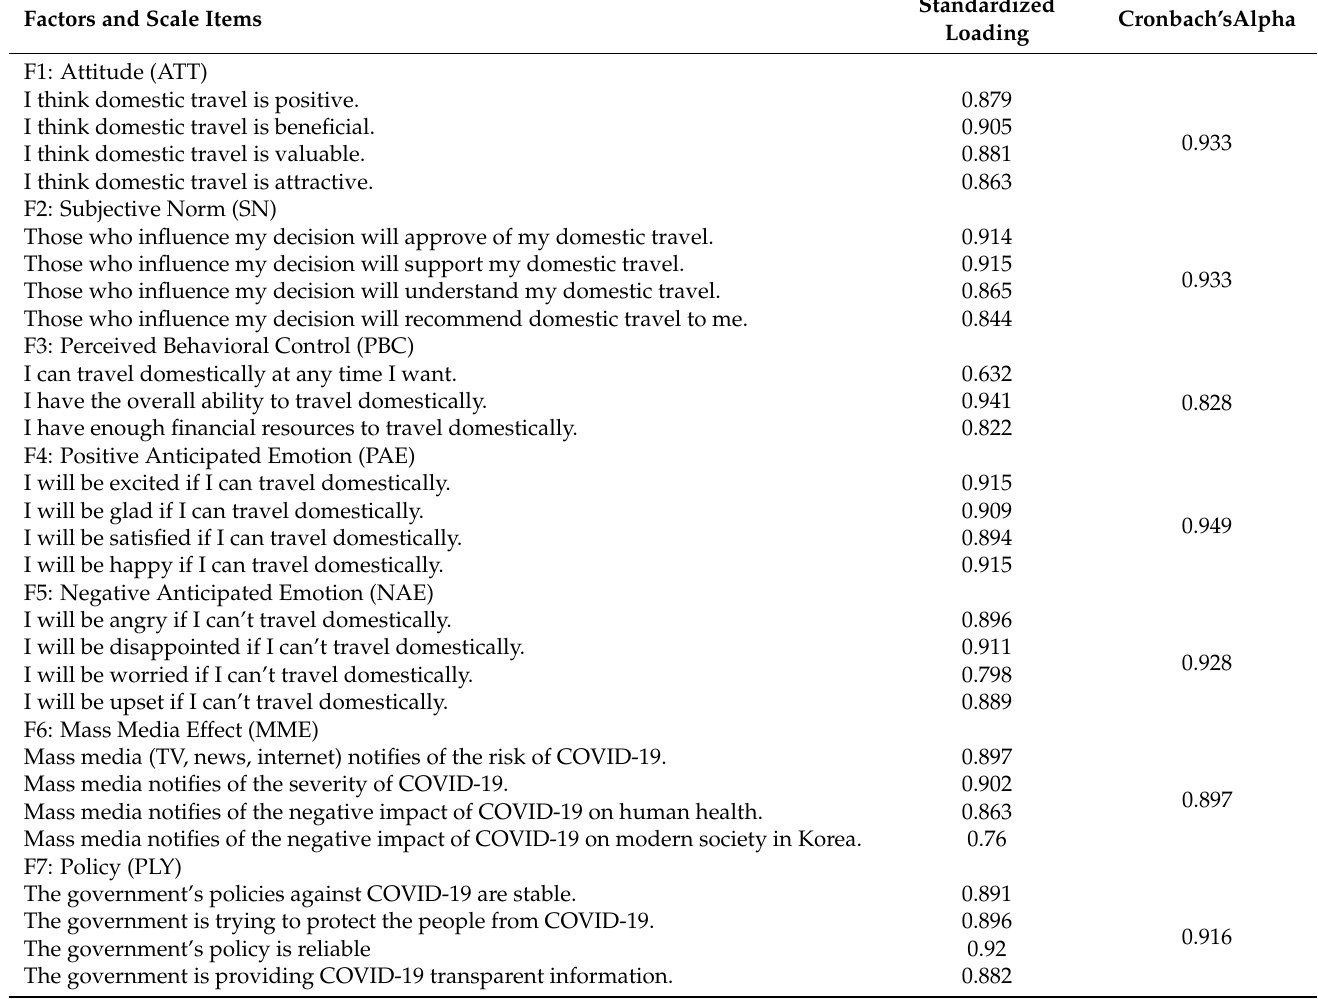
Table 3. Reliability and confirmatory factor